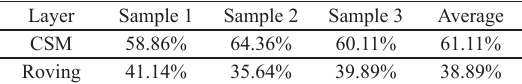
Table 6. Content of roving layers and CSM layers in each sample.